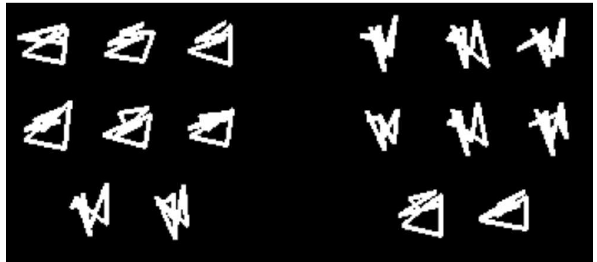
Figure 4. Examples of categories and stimuli used in Smith et al. [40]. The eight-shape groupings are two categories A and B. The six shapes in the top rows of each category are variations on the theme of the category prototype. The bottom row contains exception items that are variations on the theme of the opposing prototype. From [40]. Copyright 2010 by the American Psychological Association. Reprinted with permission.